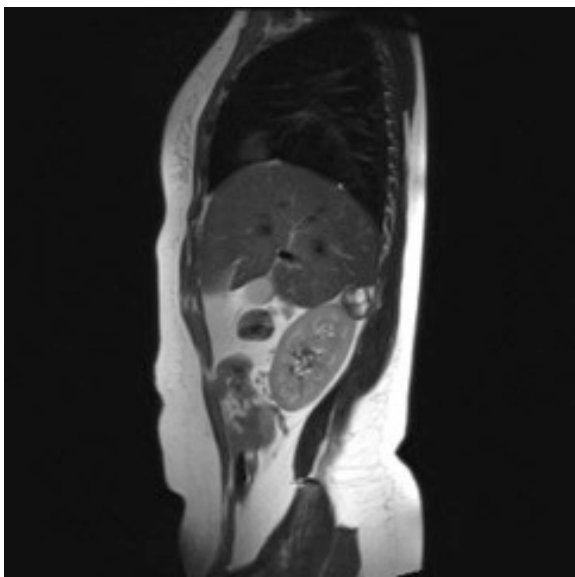
Figure 2: Rm scan T1weighted sagittal image showing the adrenal